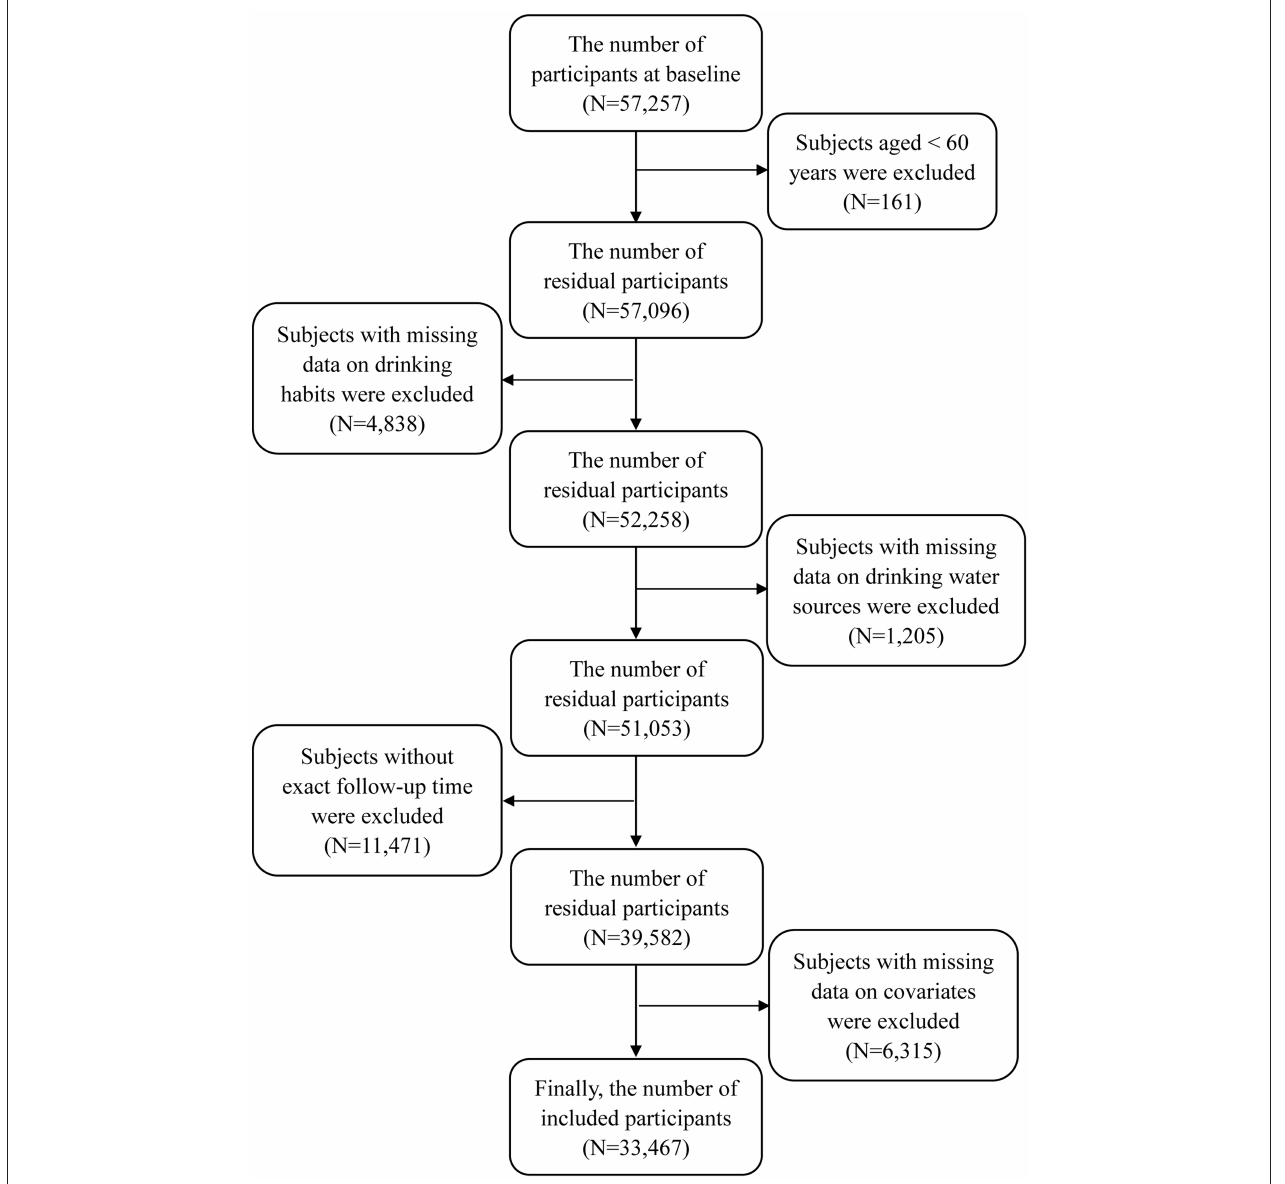
FIGURE 1 | The process of participant selection in this